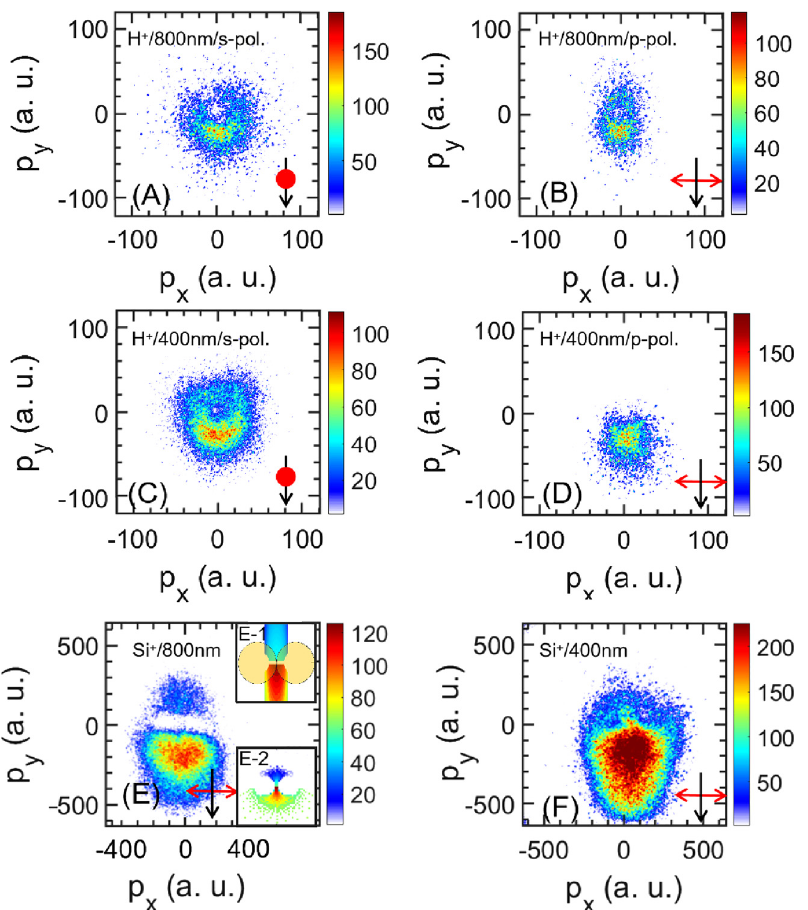
Figure 2: The single-shot momentum distri- butions for the ions ejected from the nanoparticle systemsat the low intensities. The color scale represents the intensity profile obtained on the CMOS detector. (A – D)ThemomentumdistributionfortheH + ions at excitationintensity of 17 TW/cm 2 . As indicated in the fi gures, the pulses are s - or p -polarized, at 800 or 400 nm. The black and red arrows indicate the laser propaga- tion and polarization directions, respec- tively. The red dots in (A, C) represent the laser polarization perpendicular to the xy plane (E, F) The momentum distribution for the Si + ions excited by p -polarized femto- second laser pulses at 30 TW/cm 2 at 800 nm and at 400 nm, respectively. The inserted fi gures on the upper and lower right corner in (E) are the initial charge distribution in the xy plane and the corre- sponding calculated momentum distribu-